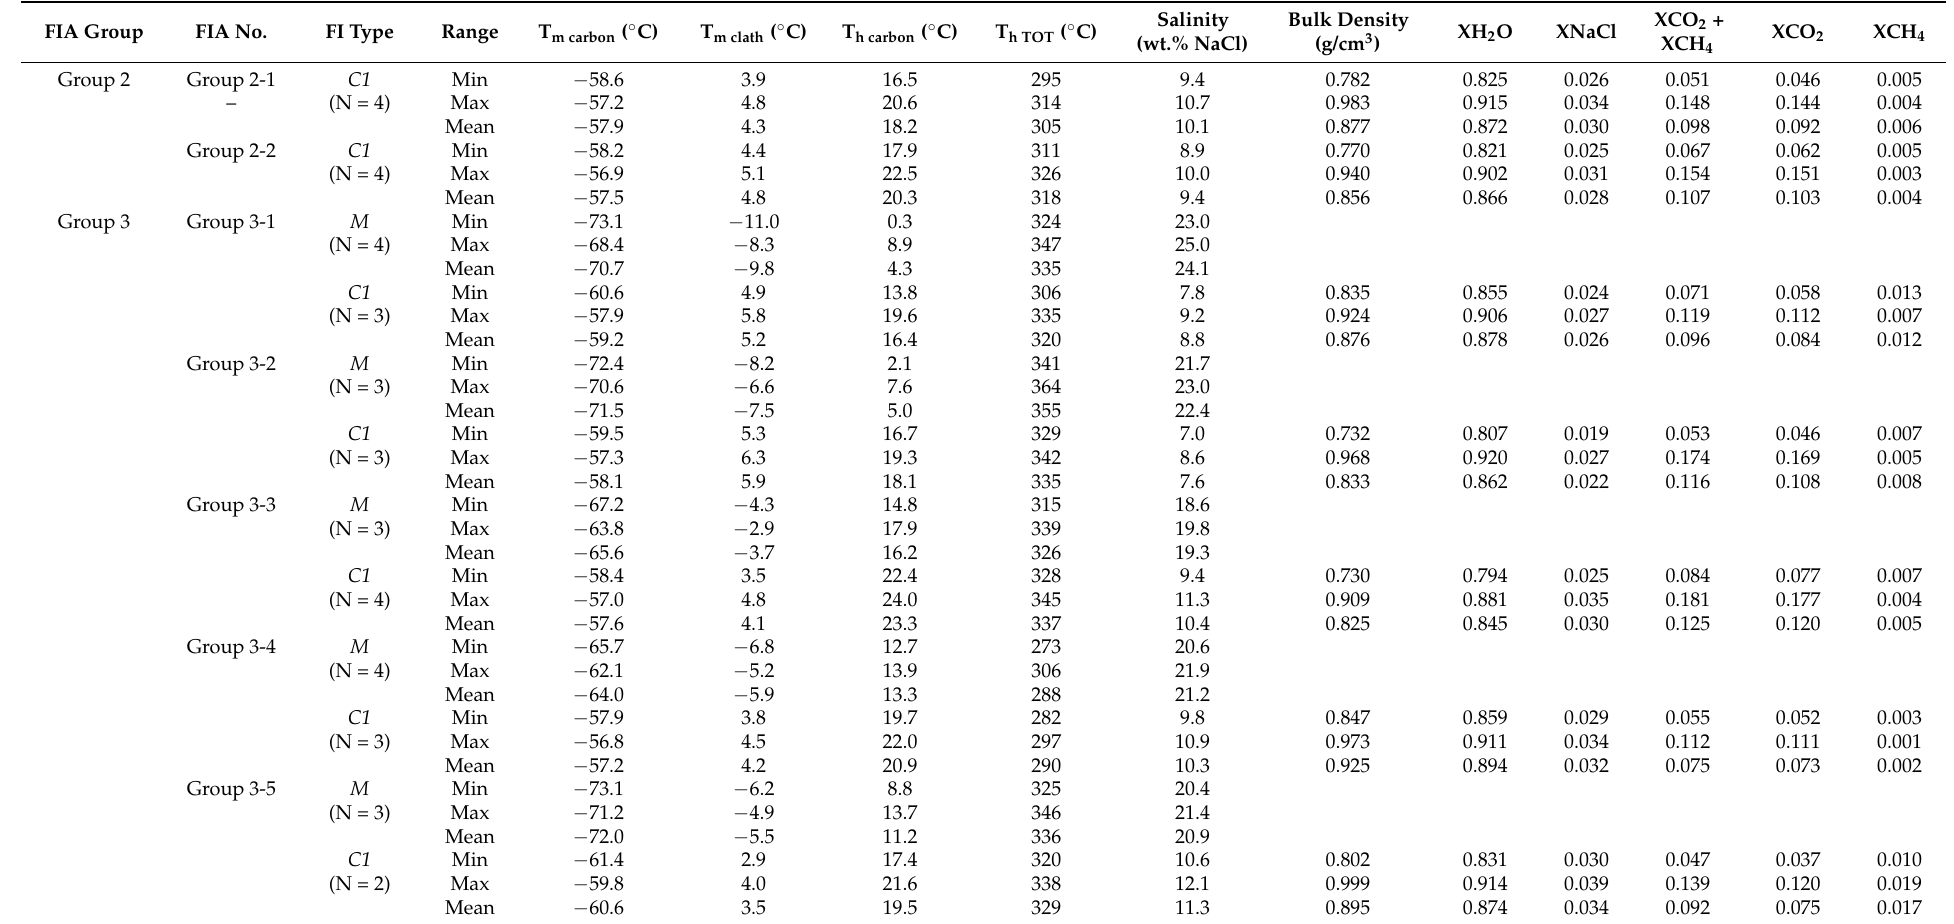
Table 3. Summary of the microthermometric data and calculated parameters for Groups 2 and 3 FIAs from stage II